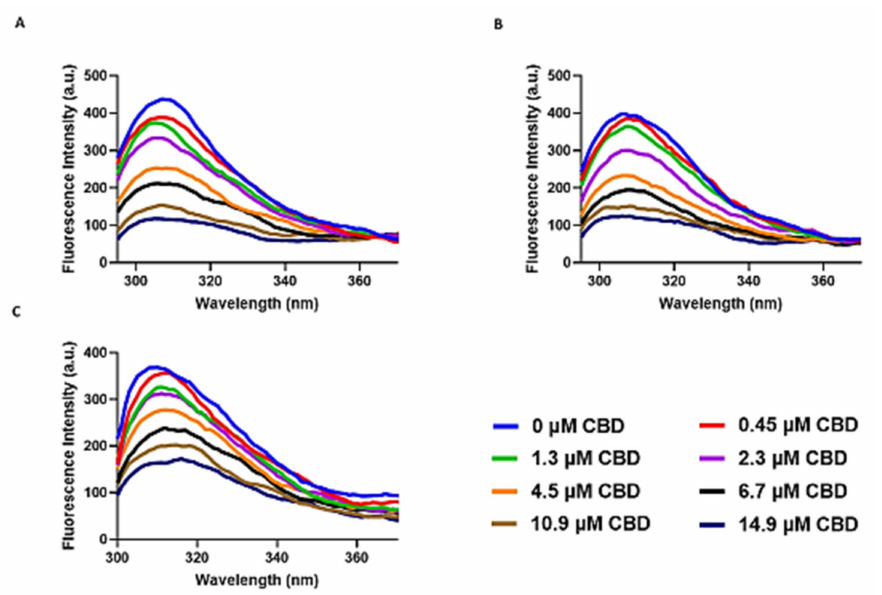
Figure 5. Intrinsic fluorescence quenching of tau protein by different concentrations of CBD ranging from 0–14.9 µ M (0 µ M, 0.45 µ M, 1.3 µ M, 2.3 µ M, 4.5 µ M, 6.7 µ M, 10.9 µ M, and 14.9 µ M) in the Tris-HCl buffer and PH = 7.5. ( A ) at 7 ◦ C ( B ) at 22 ◦ C ( C ) at 37 ◦